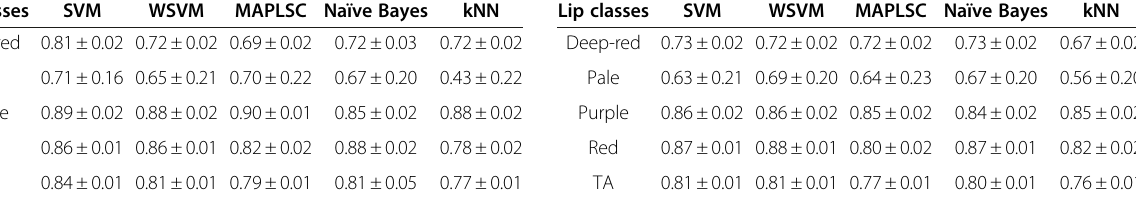
Table 4 Accuracy of lip image classification using SVM, WSVM, kNN, MAPLSC and Naïve Bayes on the features selected by IG (mean± variance) Lip